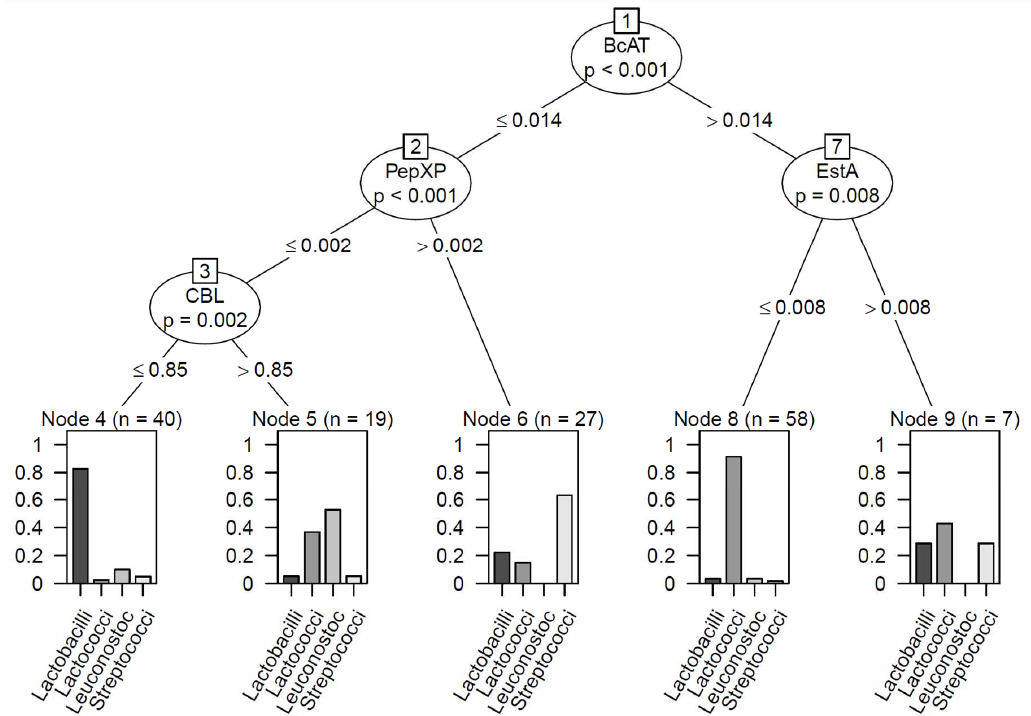
Figure 4. Decision tree to classify bacteria by genus based on enzyme activities measured after growth in BPS supplemented with 0.5% glucose. Example for interpretation: 58 strains fall in Node 8 which is defined as strains where the BcAT activity is higher than 0.014 and the esterase activity is lower than 0.008. Within that node, roughly 90% of all strains are lactococci (error rate with this prediction is lower than 10%).